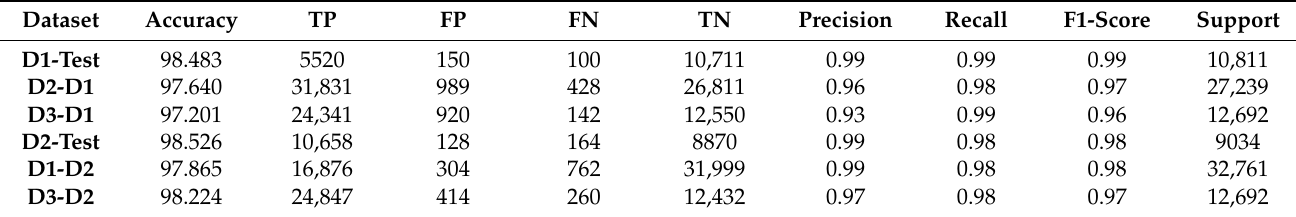
Table 6. Results of the LightGBM ML model.